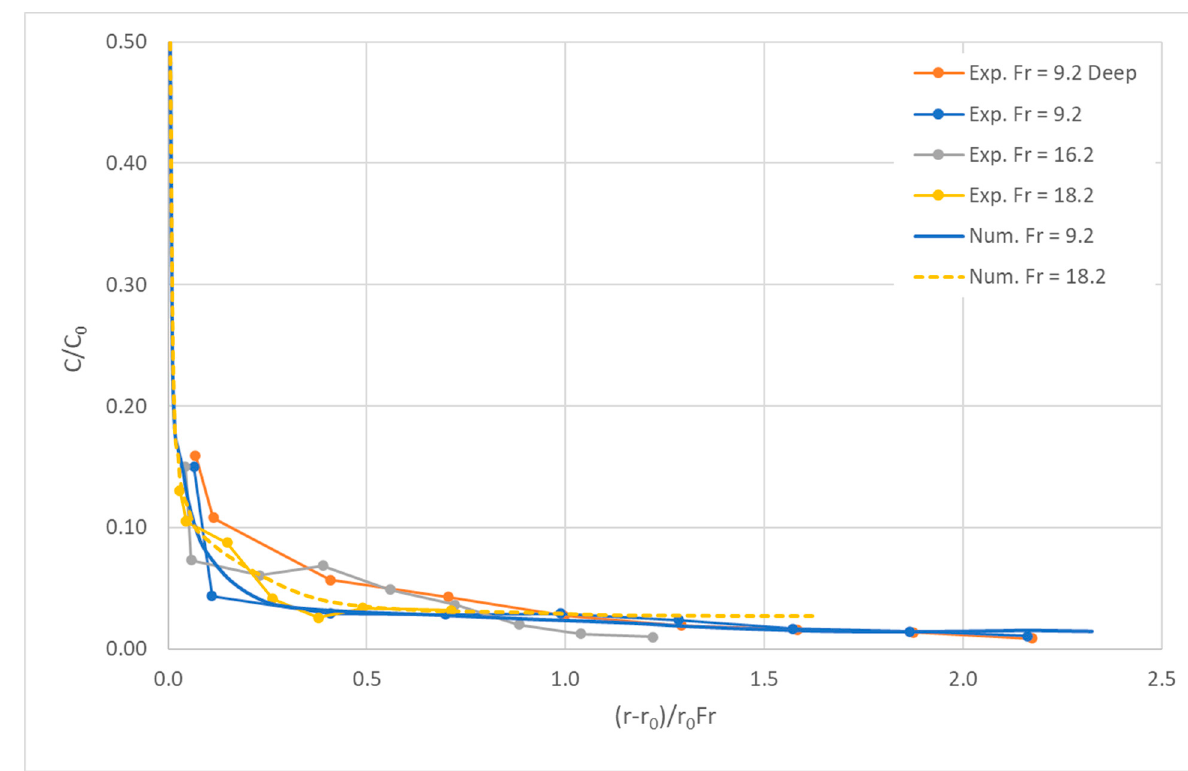
Figure 6. Concentration profiles at the nozzle level.